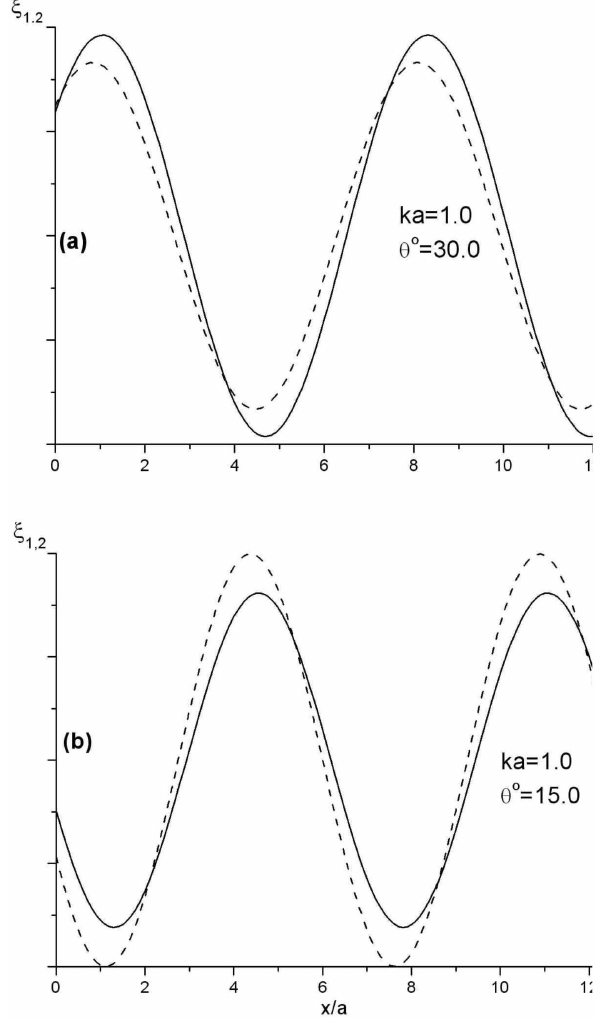
Fig. 14. Displacements of plasma flow boundaries in z-direction are shown in dimensionless units as a function of x / a . The displace- ment ξ 1 (solid line) is related to the interface between the plasma flow and the region 1 (the lobe), and ξ 2 (dashed line) is related to the interface between the plasma flow and the region 2 (the CPS). The profiles of both displacements are superimposed. Plasma densities and temperatures are the same as in Fig. 13 and (a) v A f / U 0 =0.316; (b) v A f / U 0